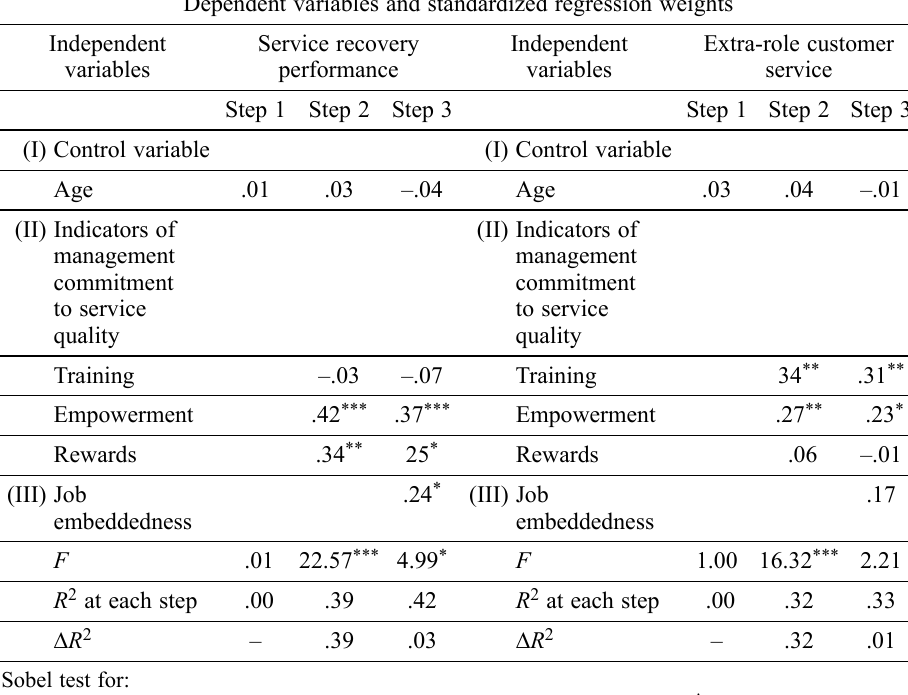
Table 4. Regression results: job embeddedness as a partial